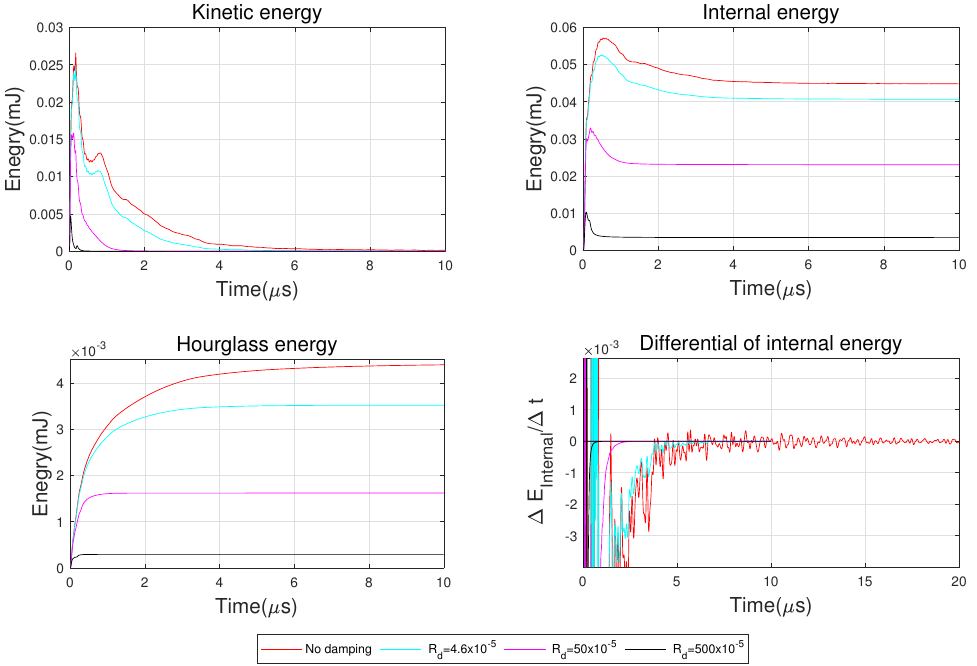
Figure 7. Energy summary of solution. The differential of internal energy ( ∆ E Internal / ∆ t ) is plotted to evaluate the stabilizing time for each damping